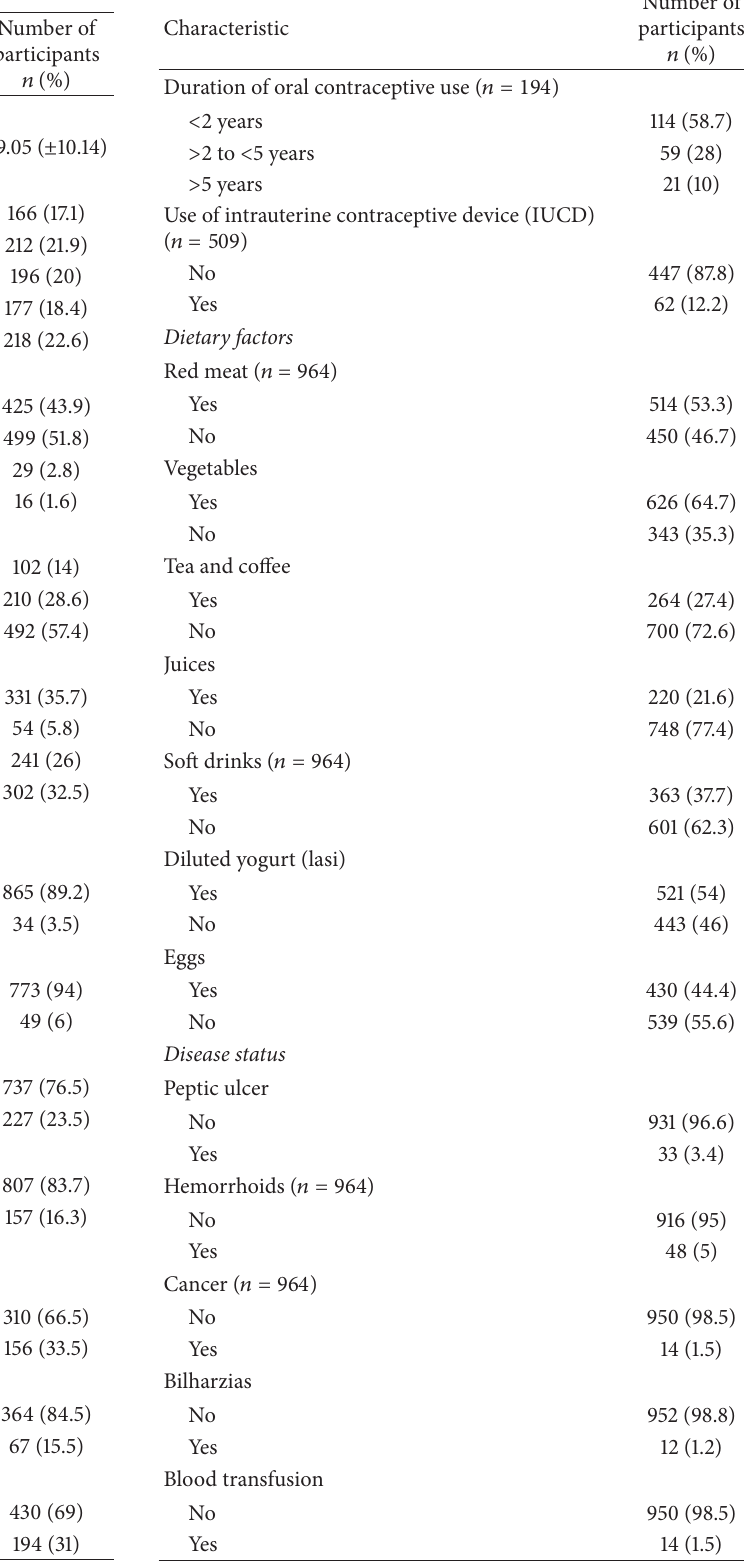
Table 2: Characteristics of child bearing age women in Riyadh, Saudi